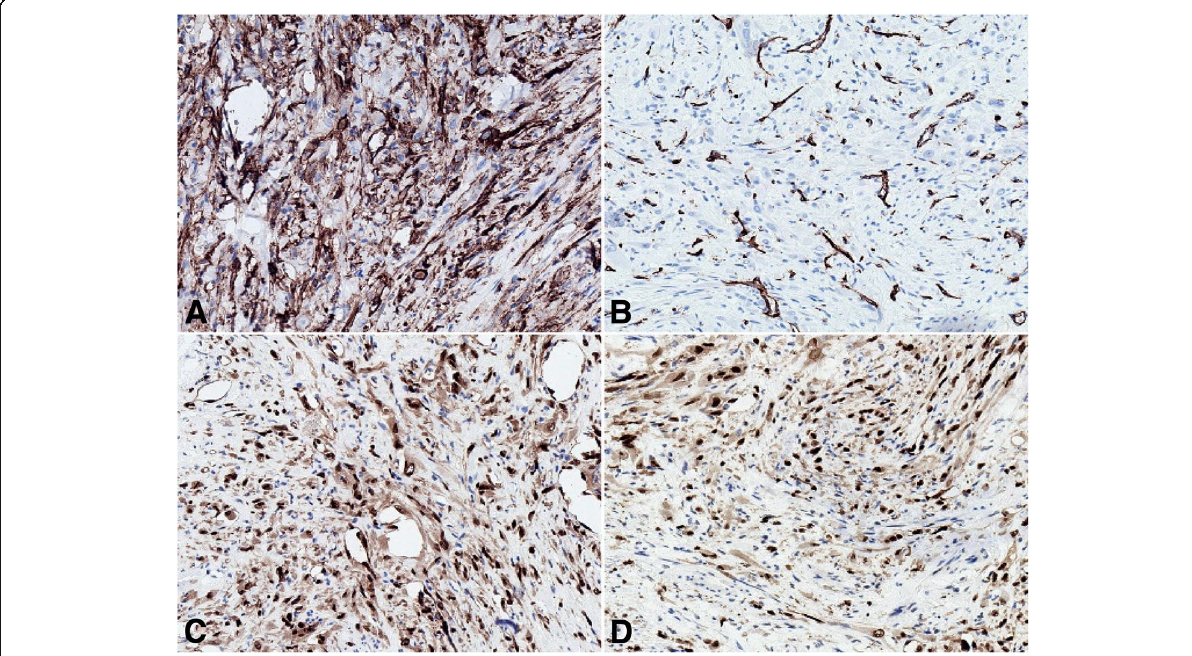
Fig. 2 Immunohistochemical panel performed on the total mastectomy material. The neoplastic cells showed linear membranous staining of CD31 ( a ) and lacked of CD34 expression ( b ). The neoplastic cells showed strong and diffuse degrees of positivity for ERG ( c